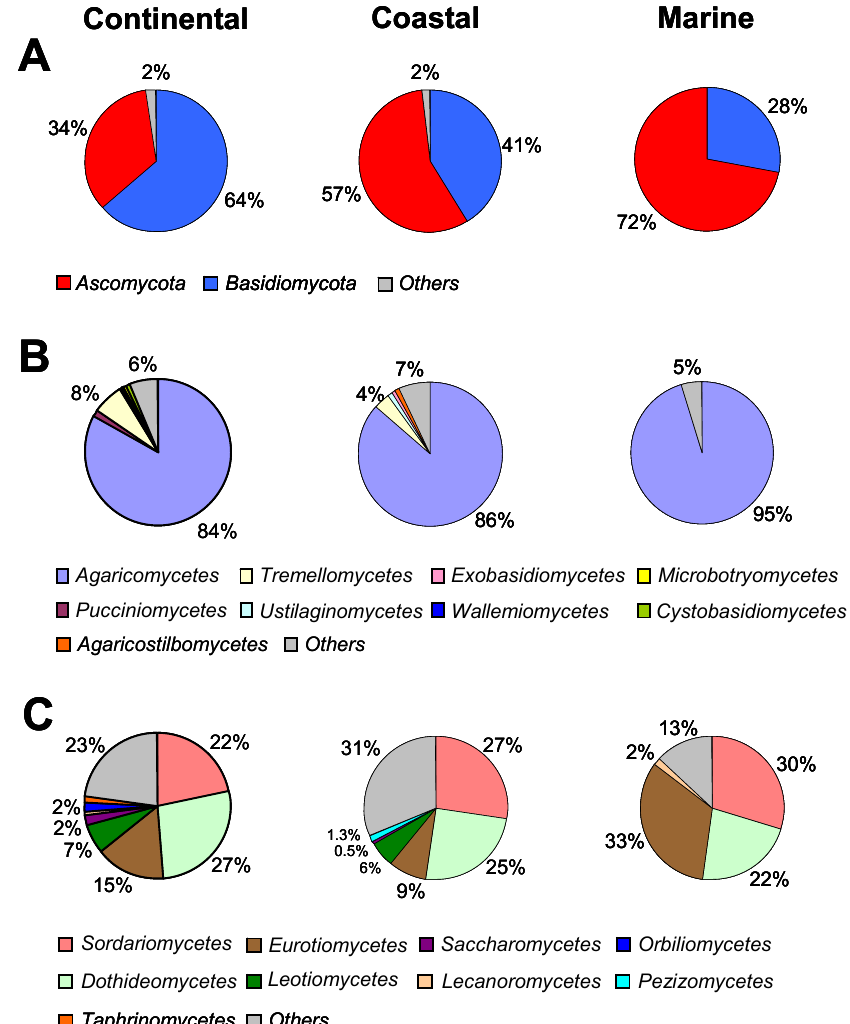
Fig. 2. Species richness of airborne fungi: mean relative proportions of different phyla (A) , different classes of Basidiomycota (B) , and different classes of Ascomycota (C) in continental (Austria, Arizona, Brazil, Germany), coastal (China, Taiwan, Puerto Rico, UK), and marine (Pacific, Indian, Atlantic, Southern Ocean) samples.